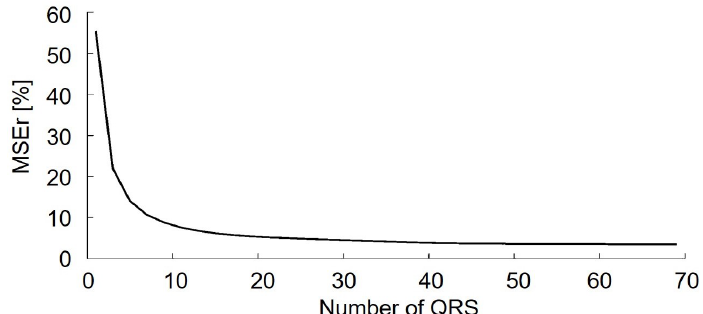
Figure 4. Relative mean squared error (MSEr) in the reconstruction selecting an increasing number of QRS complexes in the X matrix.